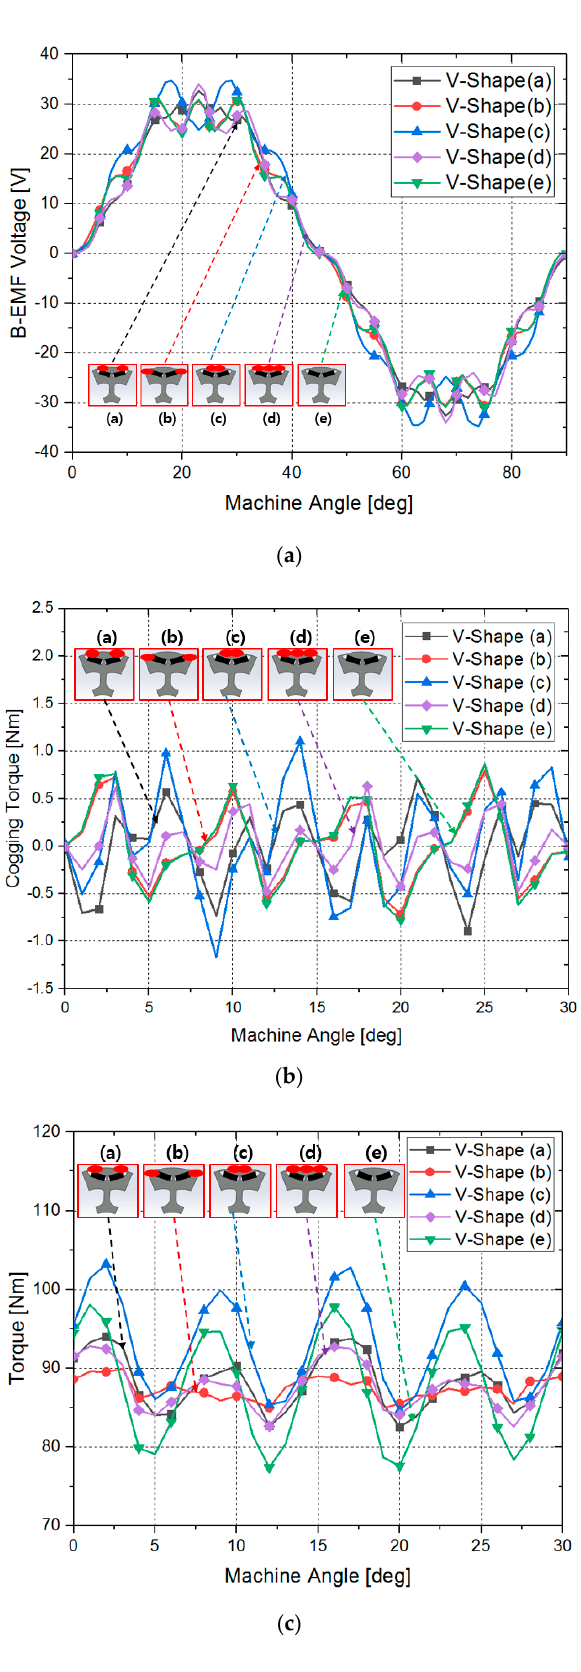
Figure 3. Back electromotive force voltage, cogging torque, and torque ripple according to notch position: ( a ) back electromotive force voltage; ( b ) cogging torque; ( c ) comparative analysis of torque